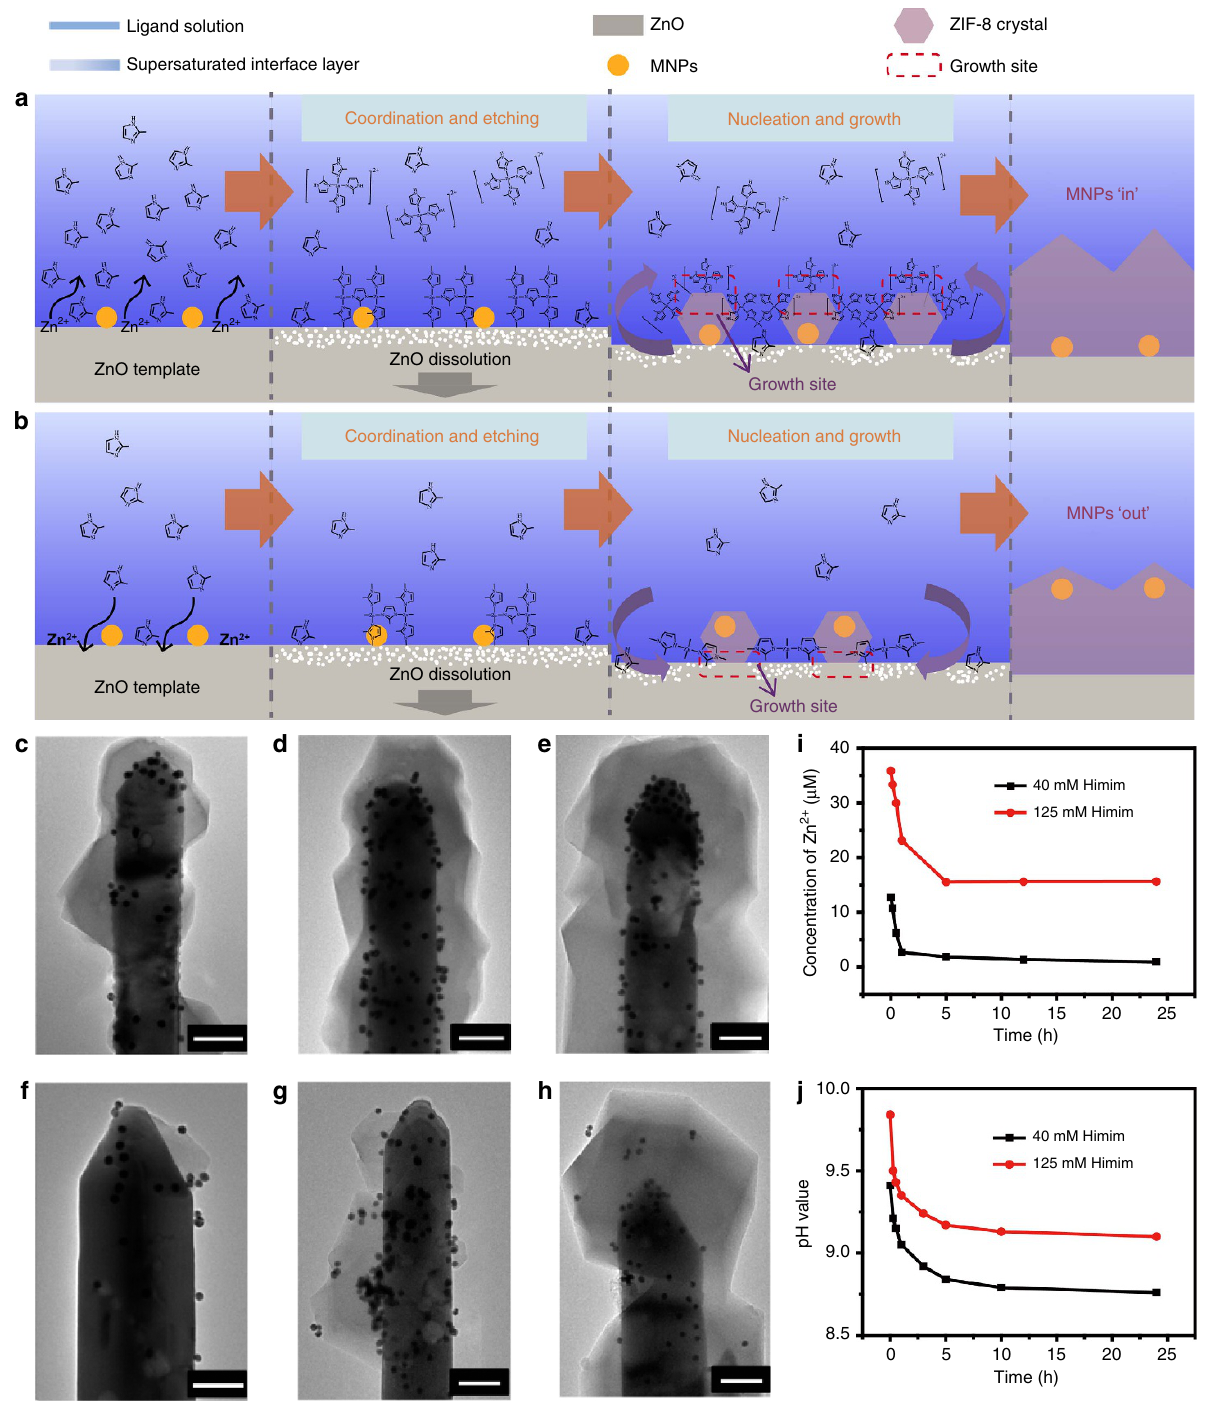
Figure 4 | Mechanism and time-dependent experiments of localization regulation of MNPs within ZIF-8. ( a , b ) Schematic view of two mechanisms for the encapsulation of MNPs into ZIF-8 with position regulation; ( c – h ) TEM images of the product synthesized with high Hmim concentration at the reaction times of ( c ) 0.5h, ( d ) 1h and ( e ) 5h and with low Hmim concentration at the reaction times of ( f ) 0.5h, ( g ) 1h and ( h ) 5h. ( i ) Concentration of Zn 2 þ versus reaction time and ( j ) pH versus reaction time of the ZnO@Au@ZIF-8 at low (black line) and high (red line) concentration of Hmim, respectively. Scale bar,